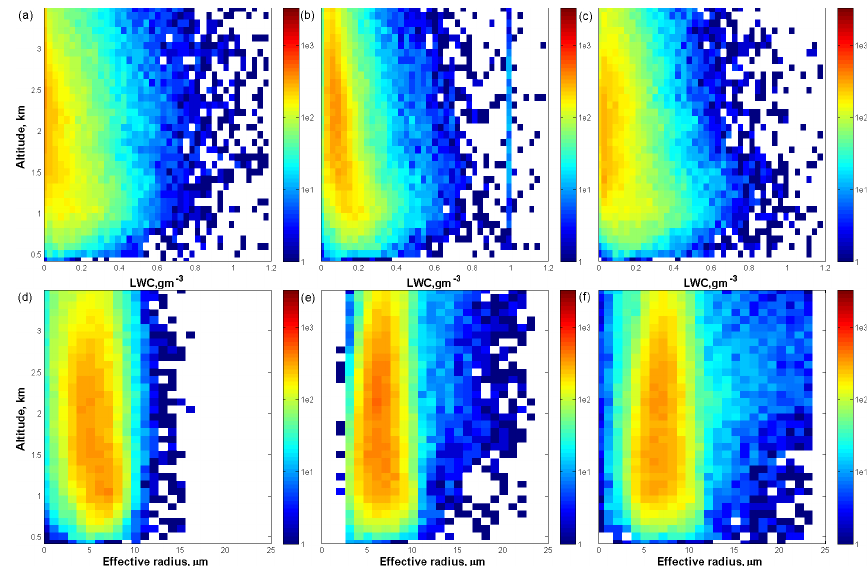
Fig. 8. CFADs of MICROBASE, UU, and UND LWC and r e e for low-level non-raining non-mixed-phase stratus from 1998 to 2006.